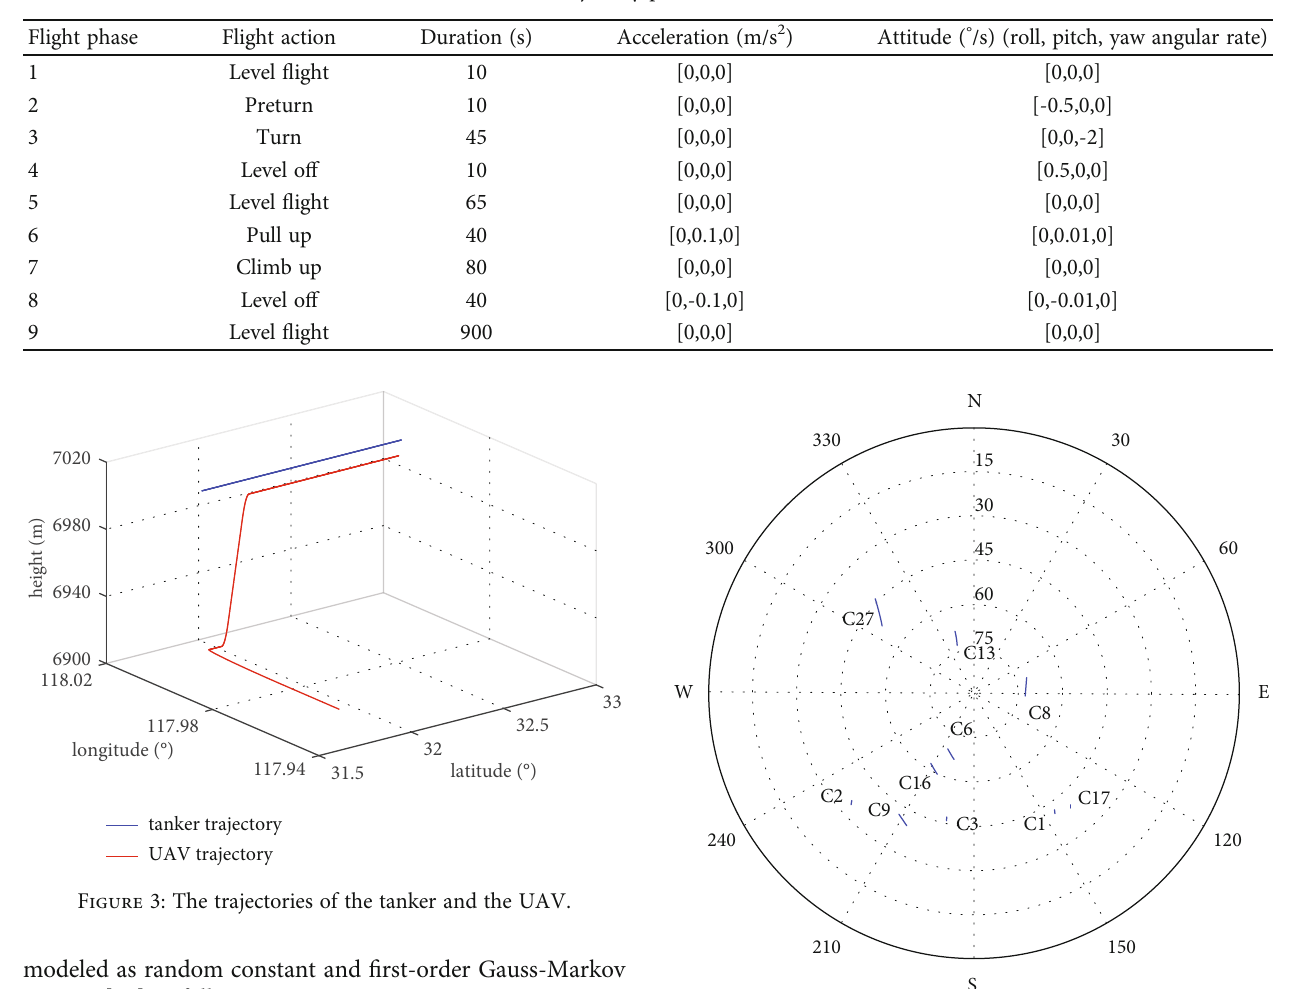
Table 1: The trajectory parameters of the UAV.